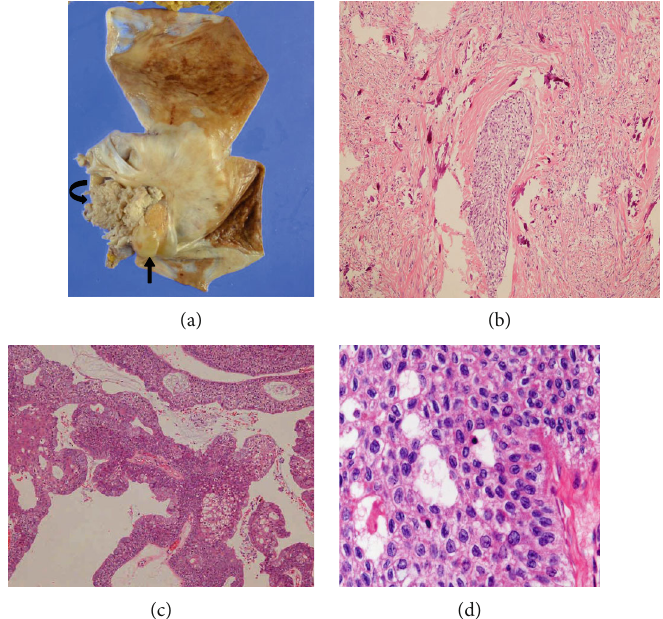
Figure 3: Pathology fi ndings for the borderline Brenner tumor. (a) Macroscopically, the solid mass is hard and yellow-tan (arrow) in color and is accompanied by the papillary tumor (curved arrow). (b) A low-power microscopic examination of the solid mass with a low signal intensity in T2WIs demonstrates solid islands of epithelial cell nests in the fi brous stroma with hyalinization and calci fi cation, indicating a benign Brenner tumor. (c) A low-power microscopic examination of the papillary tumor shows mucinous columnar epithelium and transitional epithelial cells without invasion. (d) A higher power image of the papillary tumor shows transitional epithelial cells that have longitudinal grooving with mild nuclear atypia, indicating a borderline Brenner tumor. Table 1: The summary of ADC values and maximum standardized uptake values of Brenner tumors measured in our institution in addition to previous